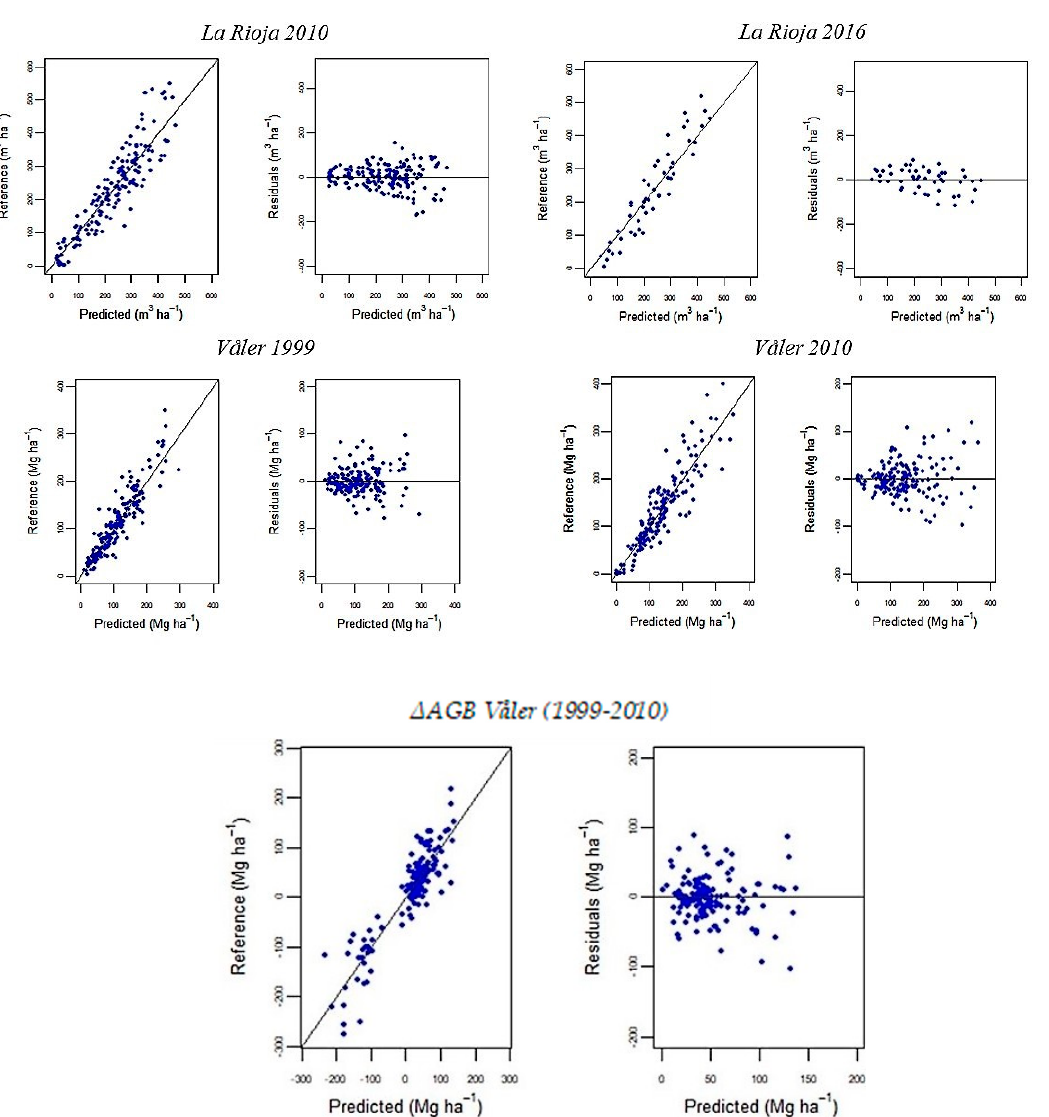
Figure 5. Observed values versus model predictions for the different RF models in La Rioja (Spain) and Våler (Norway) as well as residuals versus predicted values. Volume observations and volume predictions are shown for the La Rioja study area and biomass observations and biomass predictions for the Våler study area.